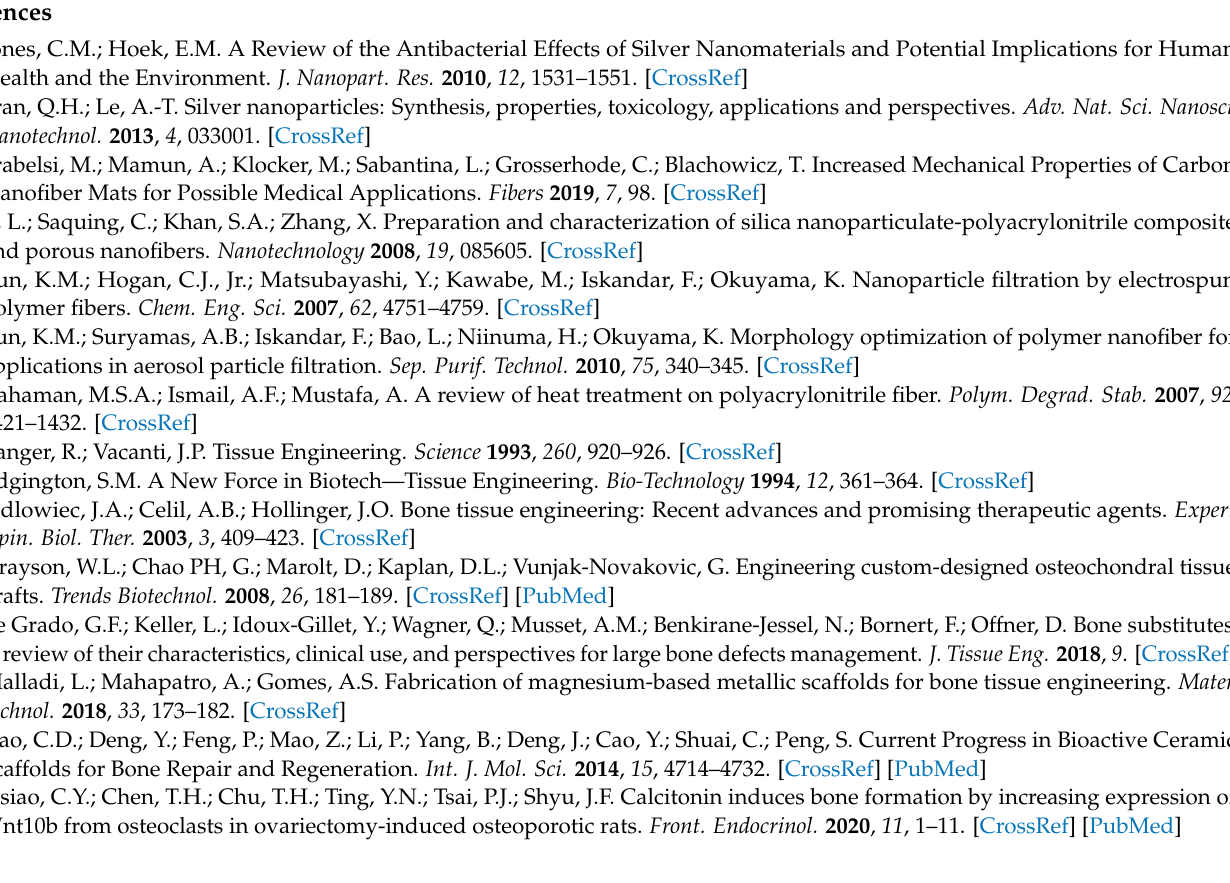
Table S3: Score system of skin irritation evaluation. Figure S1: Pathological analysis of Masson trichrome staining of regenerated tissue harvested from negative control group and urchin-like Ag–Au bimetallic nonwoven mat-treated